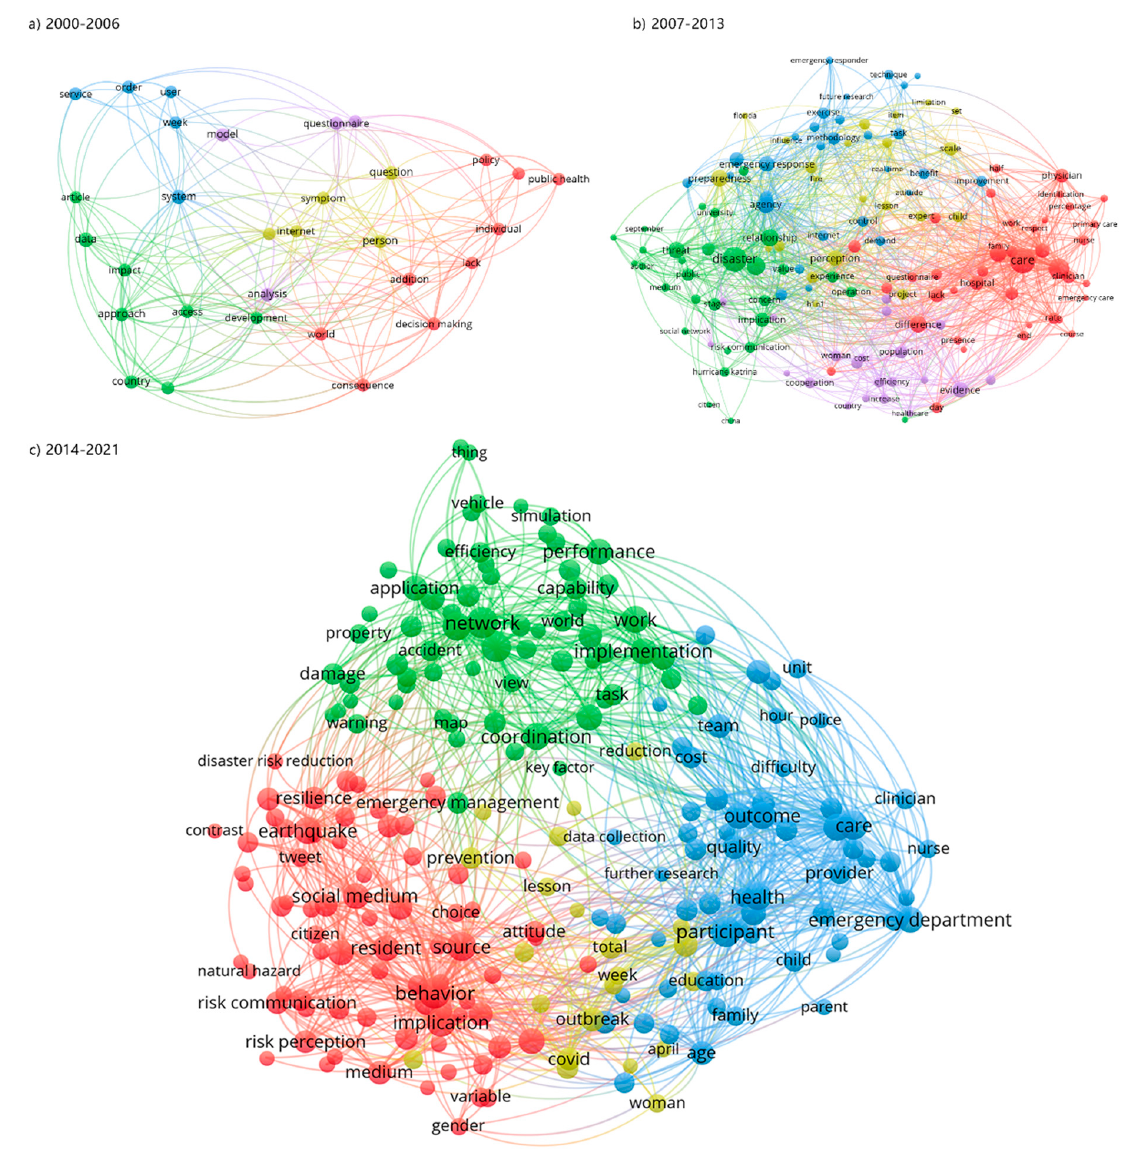
Figure 6. Keyword co-occurrence in 2000–2006, 2007–2013 and 2014–2021.